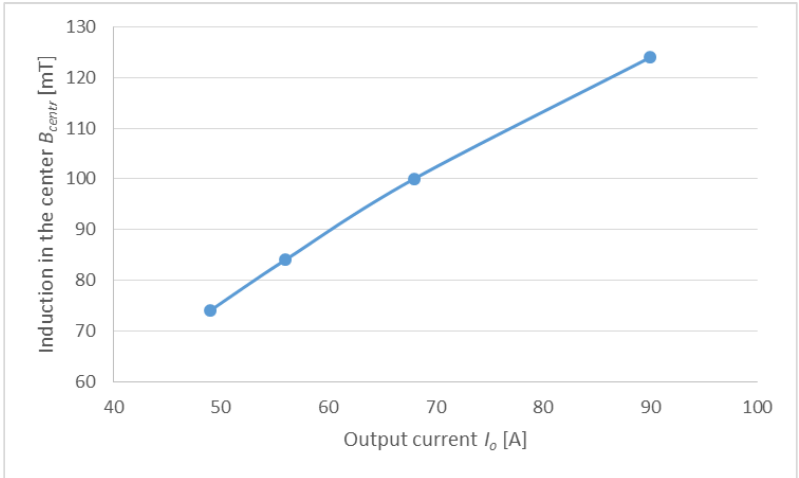
Figure 7. Magnetic induction measured in the center of the working chamber in the function of the windings current.